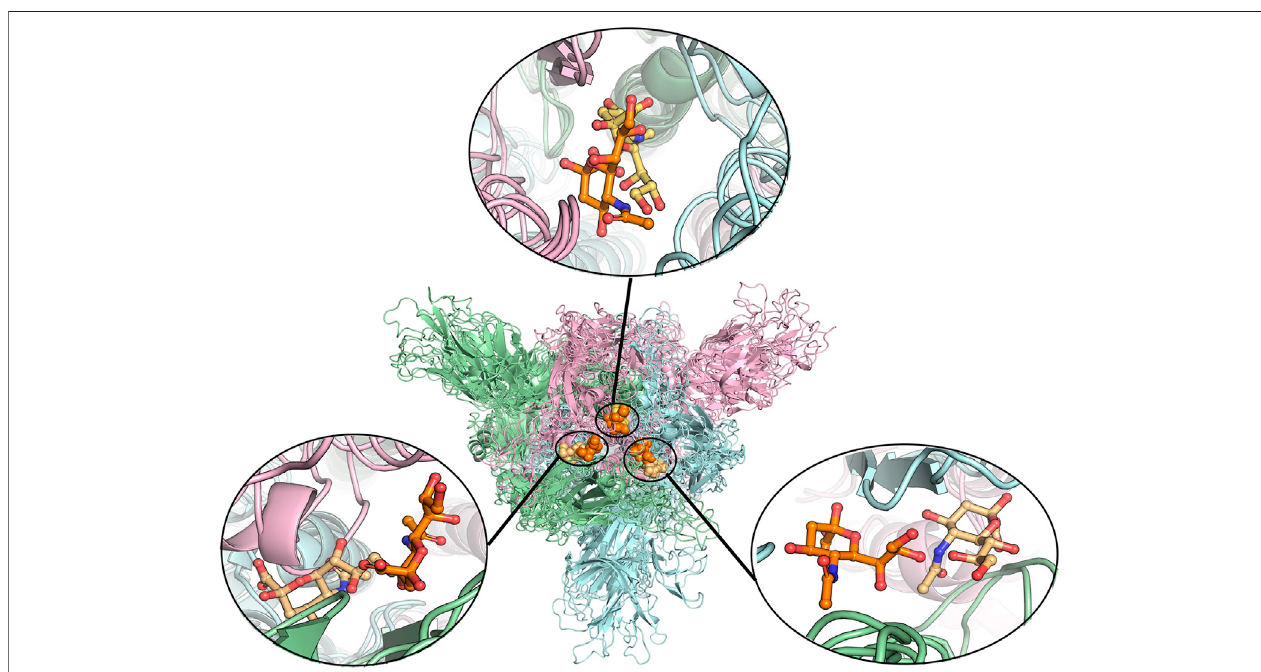
FIGURE 3 | Alignment of different protein structures to identify the overlapped sialic acid-binding positions, that is, SA_6, SA_7, and SA_24. The fi gure shows the alignment of these fi nal stable complex structures of sialic acid with spike protein, generated by the MD simulations starting from those four different protein structures. The sialic acid-binding positions, i.e., SA_6, SA_7, and SA_24 were found to be conserved in “ down ” conformational states of the spike protein and to be observable in “ up ” conformational states. Position SA_6 is between chain B (pale-blue) and chain C (light-pink), position SA_7 is between chain A (pale-green) and chain B and position SA_24 is between chain A and chain C. The stable bound sialic acids are shown in different colors. Three sialic acids in the glycosylated “ down ” conformational state are shown in orange color. Two sialic acids in the unglycosylated “ down ” conformational state are shown in light orange color. One sialic acid bound on the glycosylated “ up ” conformational state is shown in yellow-orange color. The detailed interaction modes for the bound modes are shown in Figure 4 and Supplementary Figures S7, S8 . No stable sialic acid appears in these three positions for the glycated “ up ” state.